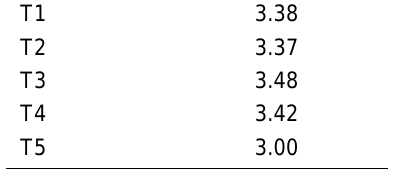
Fresh Cob Yields of Swan at 90 DAP